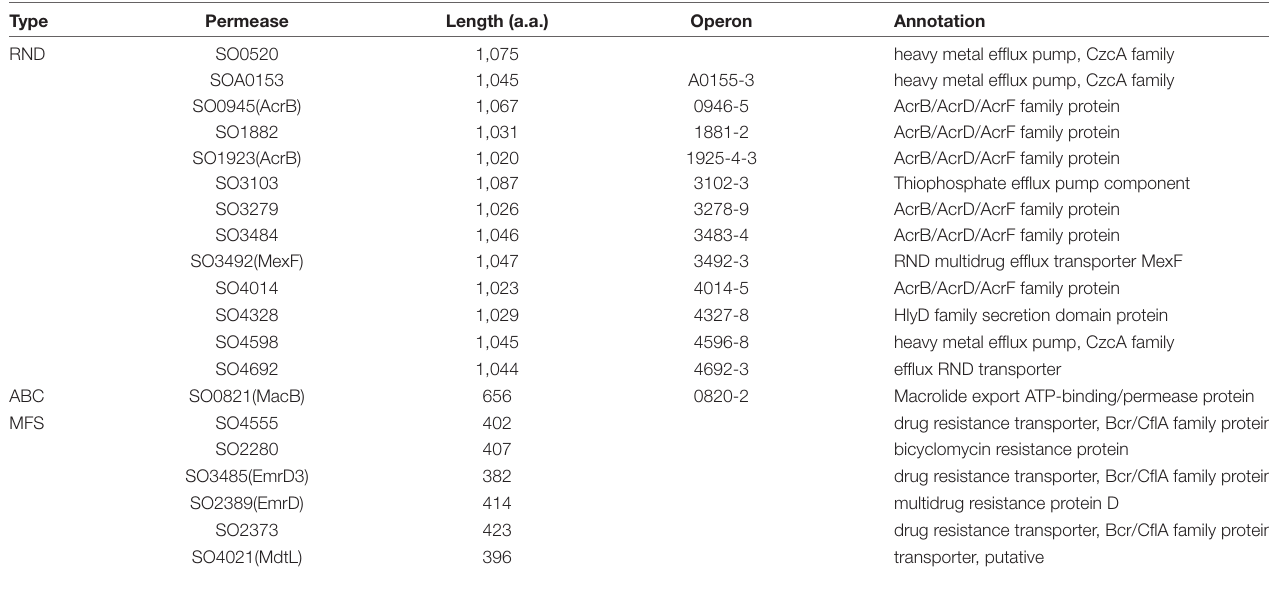
TABLE 1 | Putative siderophore exporters of S. oneidensis